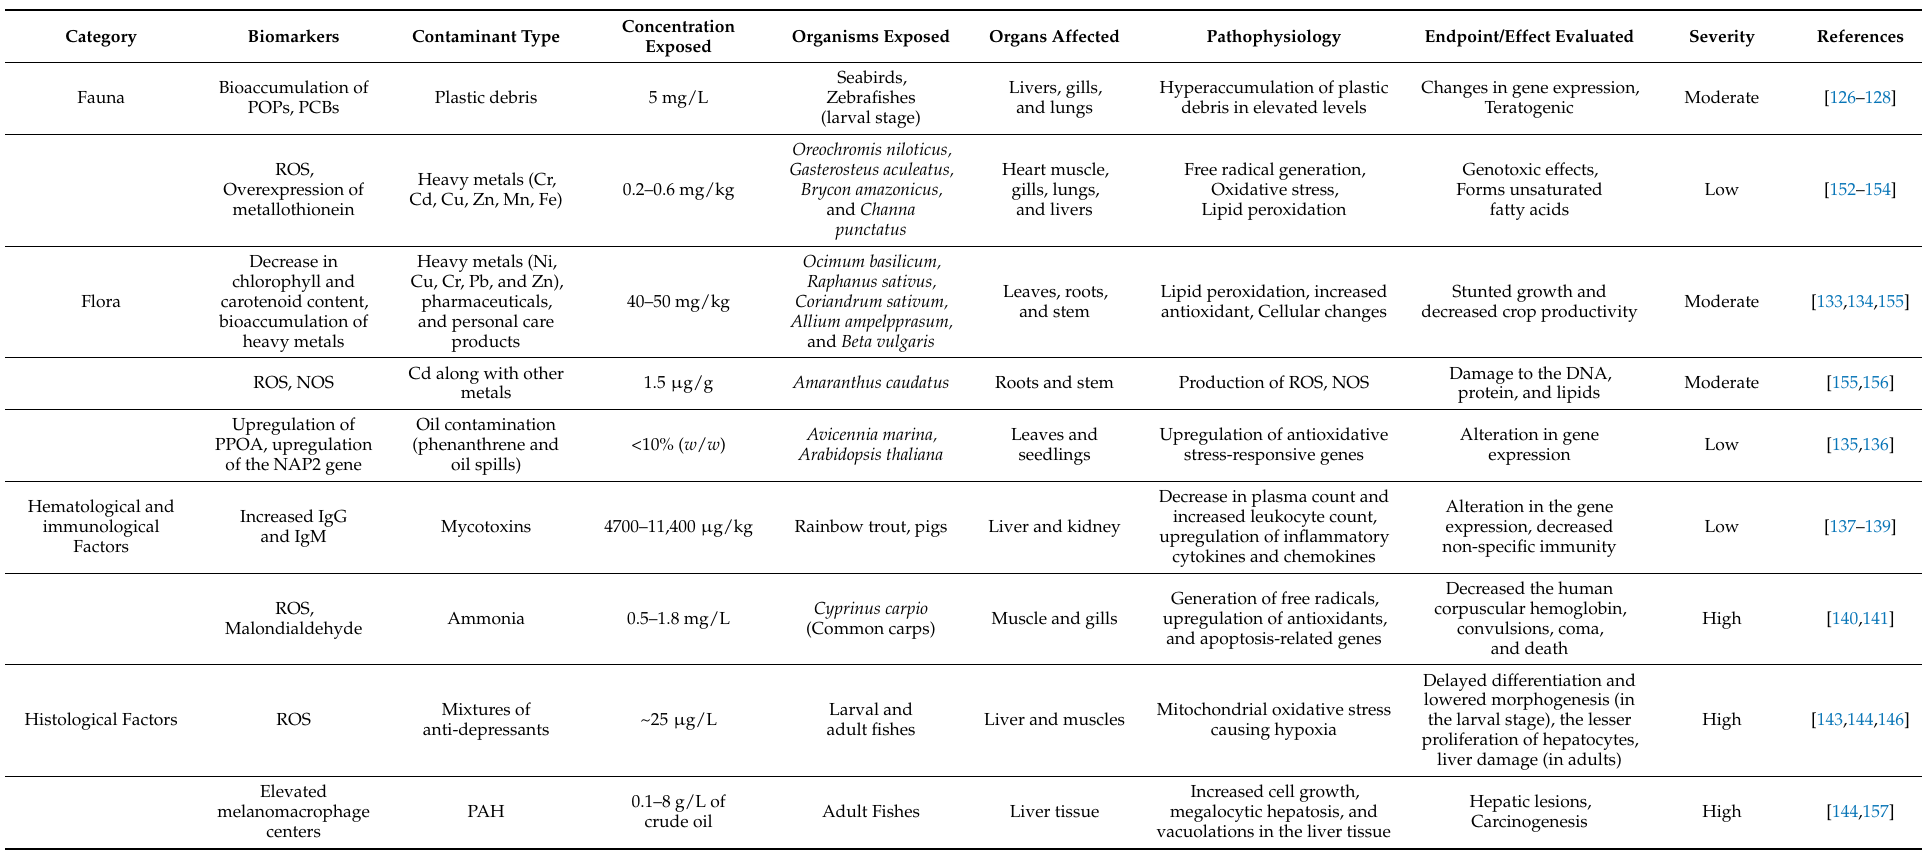
Table 1. This table provides a complete overview of the categories of biomarkers, contaminants’ combined effects, mechanism, and severity in various